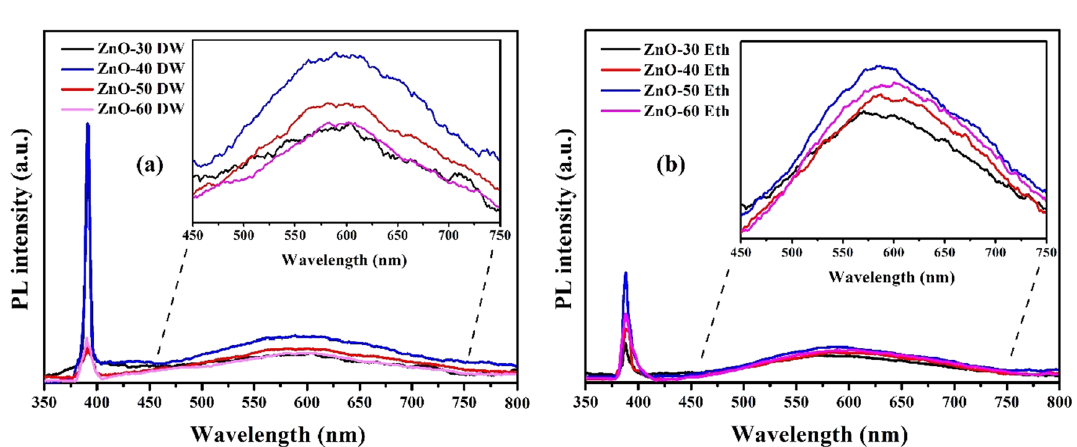
Figure 9. PL spectra of ZnO thin films grown in ( a ) DW and ( b )